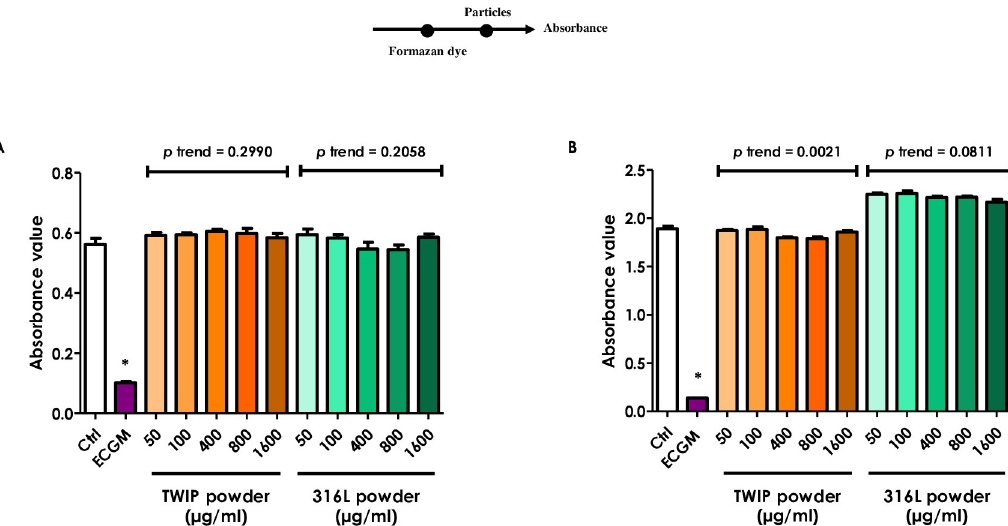
Fig 7. TWIP steel particles do not quench the absorbance of the formazan product. The water-soluble tetrazolium salt (WST- 1) was converted by metabolically active cells (HUVECs) or Vitamin C (0.5 mM) into the formazan dye and then added to increasing concentrations of TWIP steel or 316L steel particles. Absorbance was immediately measured at 450 nm, with 690 nm as reference. Results are reported as absorbance value of particles added to the formazan dye cleaved by cells (A), or ascorbic acid (B). ECGM: 100% cell culture medium. Values are means ± SEM (n = 4), � p < 0.05 relative to control (One-way ANOVA followed by a Dunnett’s multiple comparison). The trend test included controls. On the top: timeline of experiment setup.